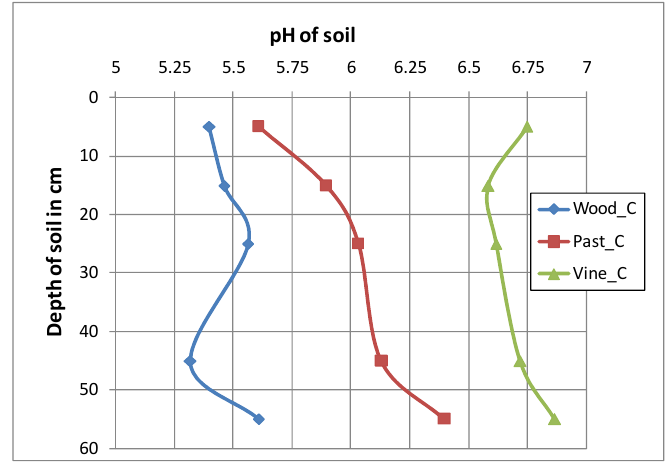
Figure 3. pH of soil under different land use and land cover (LULC) at varying depths. Note that: Wood_C = Woodland consistency, Past_C = Pasture/scrubland consistency, Vine_C = Vineyard